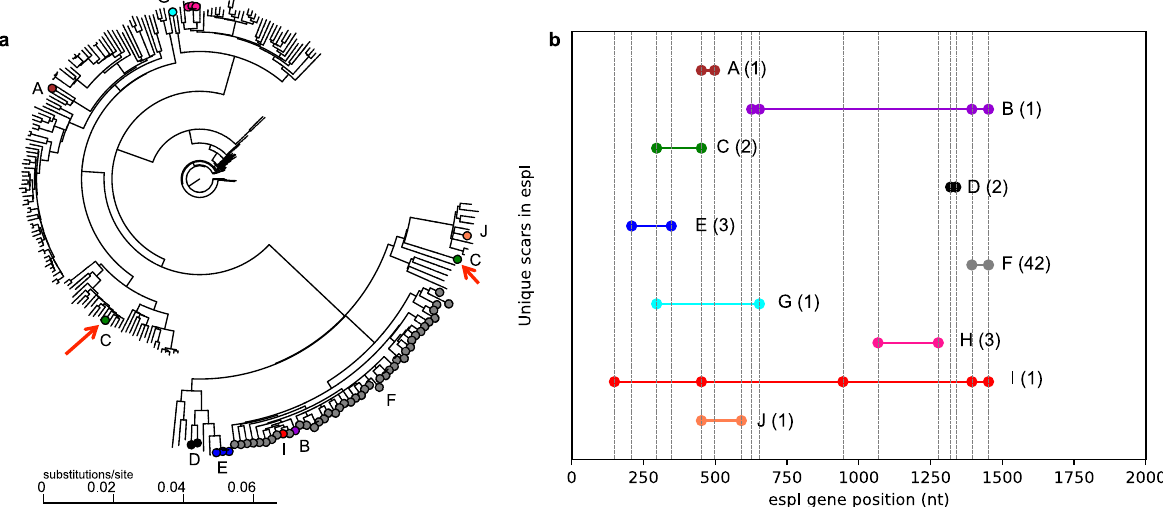
Fig. 6 Unique frameshift scars in the espI gene. a A Bayesian tree of the 57 isolates that had scars in the espI gene and 200 randomly selected phylogenetically distant isolates is shown. The ten unique scars are identi fi ed by letters A – J as well as different colors. Absence of a colored node indicates a randomly selected independent isolate without a scar in the espI gene. Identical scars indicated in green nodes (scar C, red arrows) appeared independently in phylogenetically distant isolates, suggesting convergent evolution. Although unrooted, the Newick tree visualizations are implicitly rooted at the top node. b The indels ( fi lled circles) in the ten unique scars (each identi fi ed by a different color and letter) seen in our dataset of 5977 isolates are shown along the length of the espI gene. The number of isolates that have a given scar is indicated in parenthesis. The gene positions where scar indels occurred are shown by vertical dashed gray